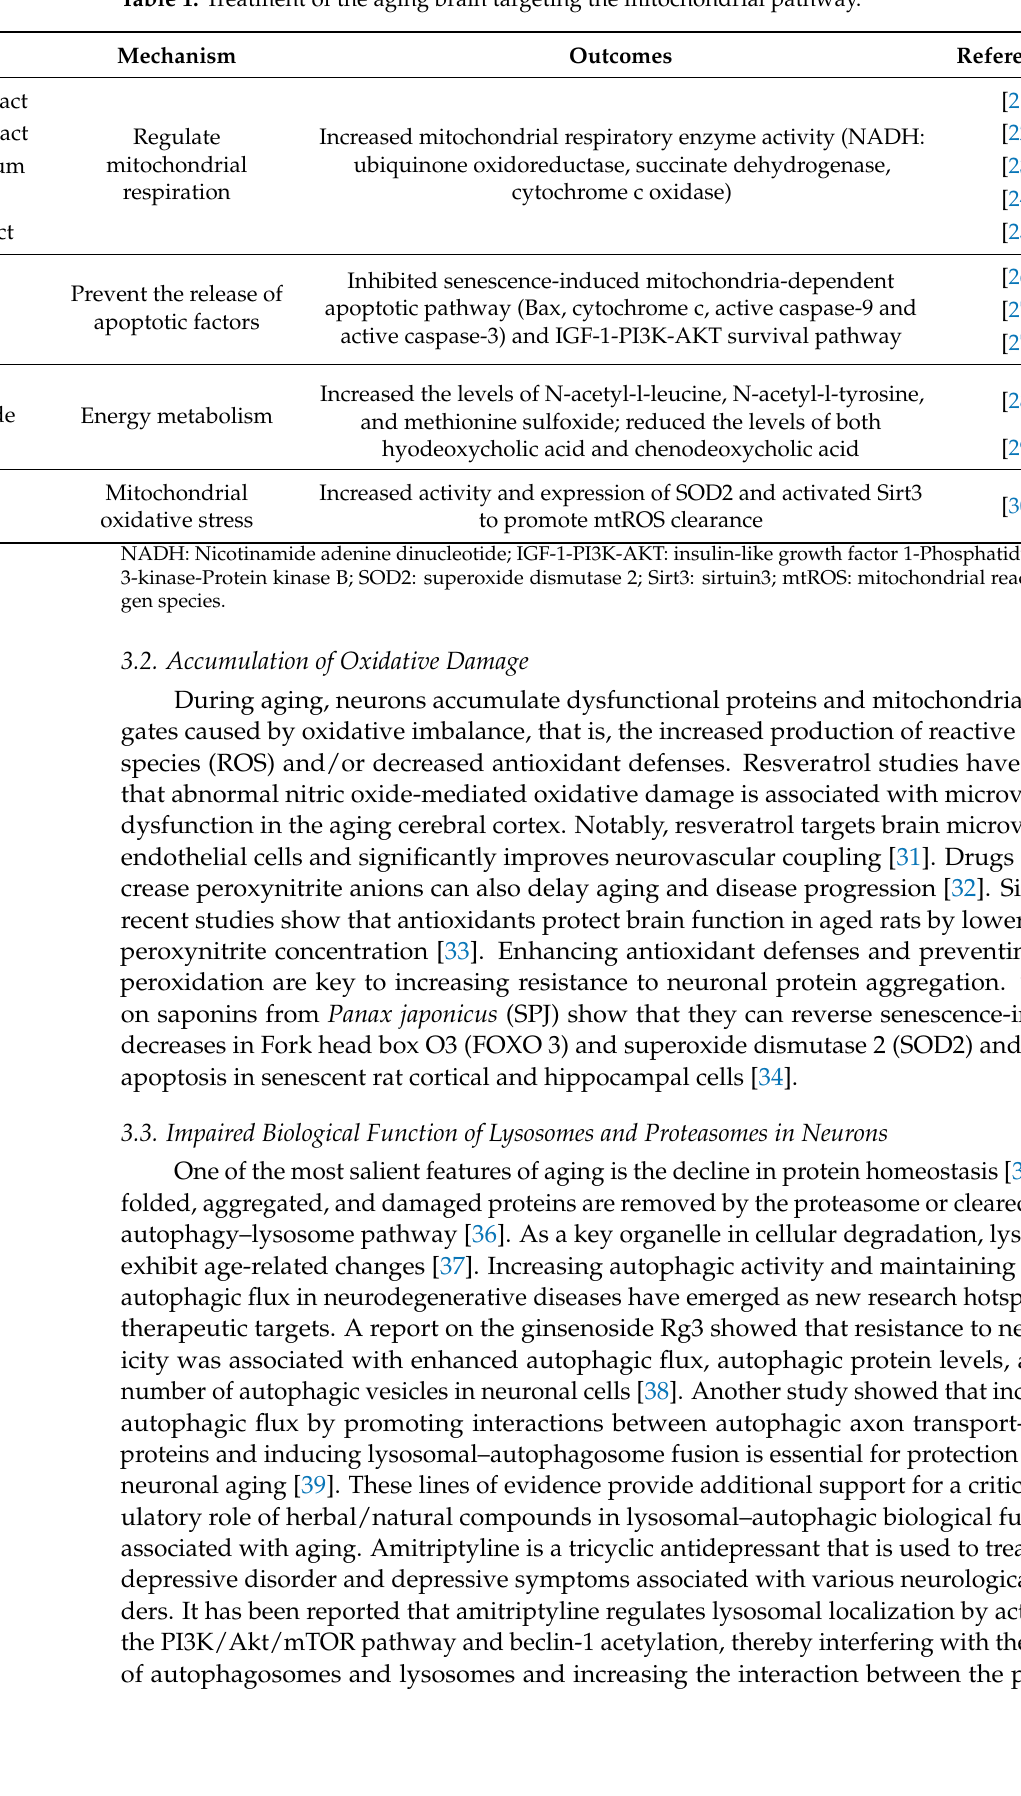
Table 1. Treatment of the aging brain targeting the mitochondrial